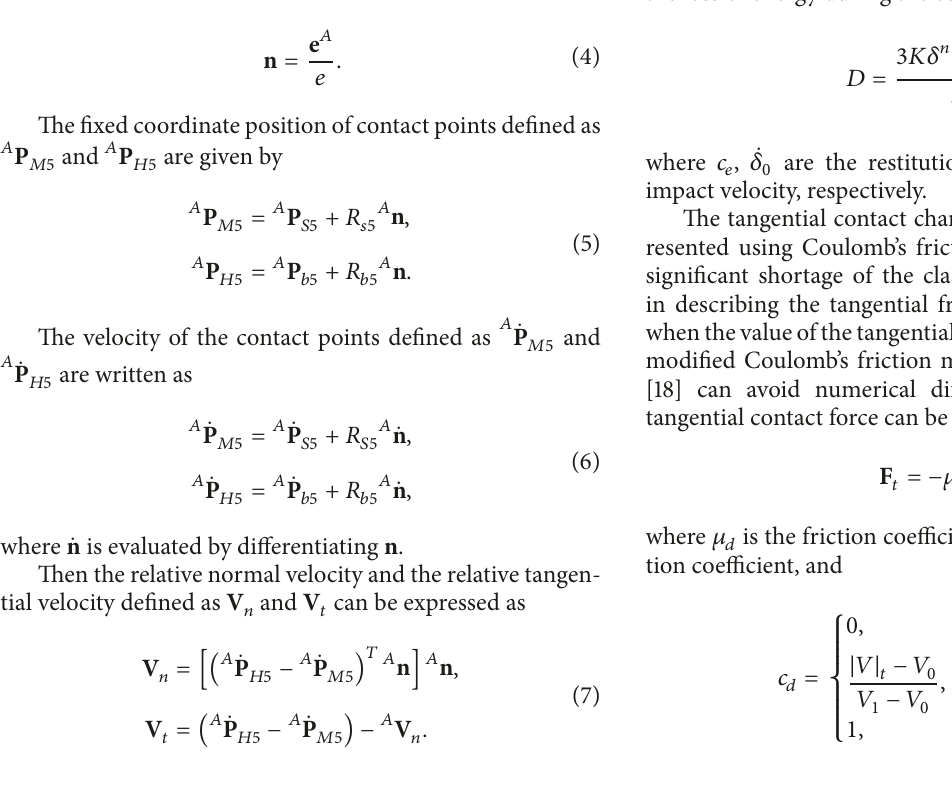
where 𝑒 is the magnitude of the eccentricity vector, and 𝑒 = √ 𝐴 e 𝑇 ⋅ 𝐴 e = √ 𝐴 𝑒 2 + 𝐴 𝑒 2 + 𝐴 𝑒 2 𝑐 is joint clearance, and 𝑐 = 𝑥 𝑦 𝑧 , 𝑅 − 𝑅 𝑅 𝑅 𝑆5 𝑏5 , and 𝑆5 and 𝑏5 are the radius of socket and ball,